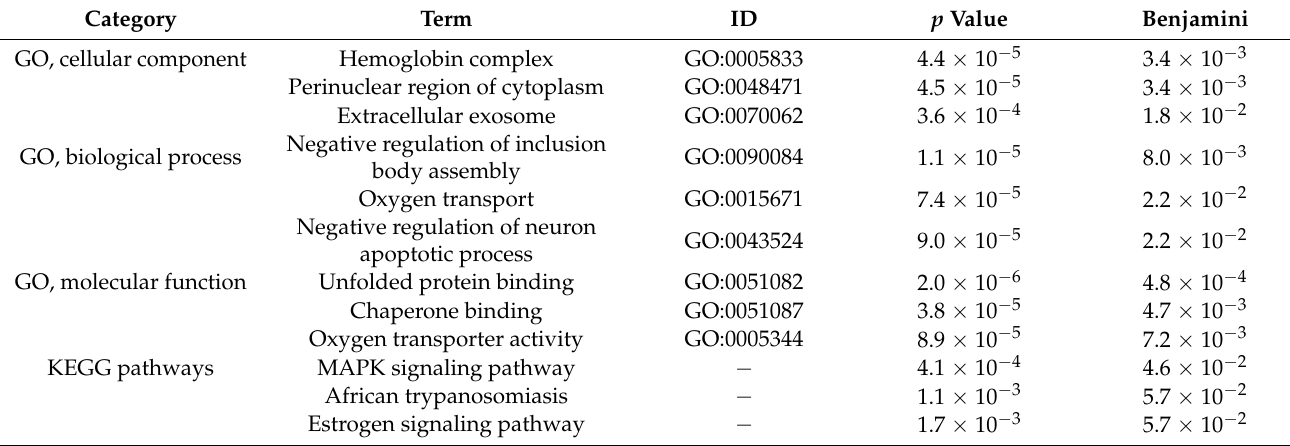
Table 4. DAVID Functional Analysis and KEGG pathway Results of DEGs in the HMLS vs. NaCl Group.